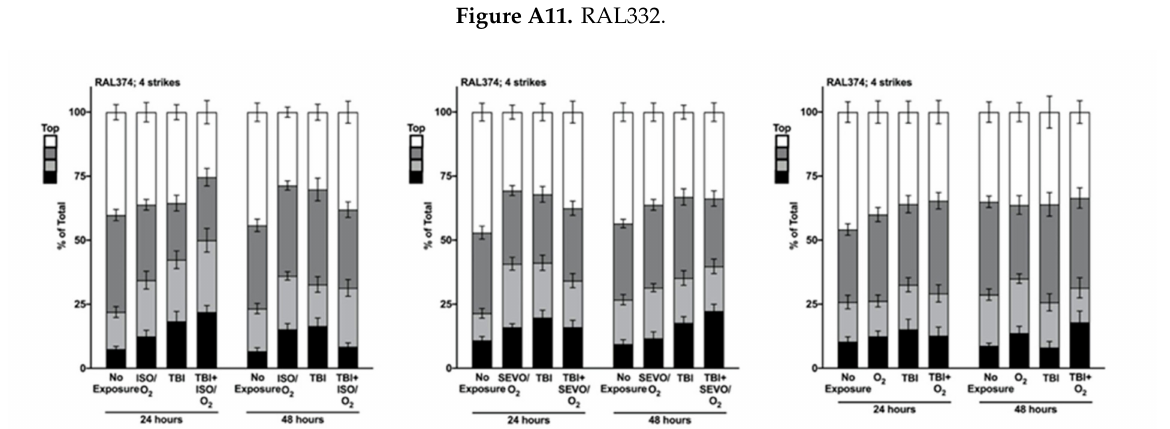
Figure A11. RAL332.